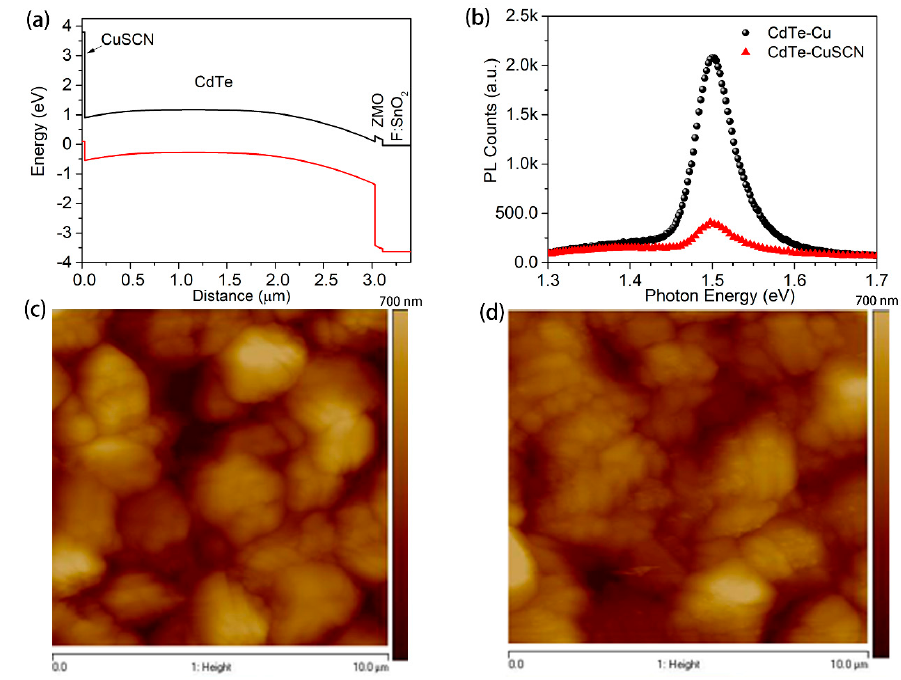
Figure 1. ( a ) Solar cell capacitance simulator (SCAPS) modeling determined band diagram for the device with a structure of fluorine doped tin oxide coated glass (FTO) / zinc magnesium oxide (ZMO) / cadmium telluride (CdTe) / copper thiocyanate (CuSCN) / Au. ( b ) Steady-state PL spectra